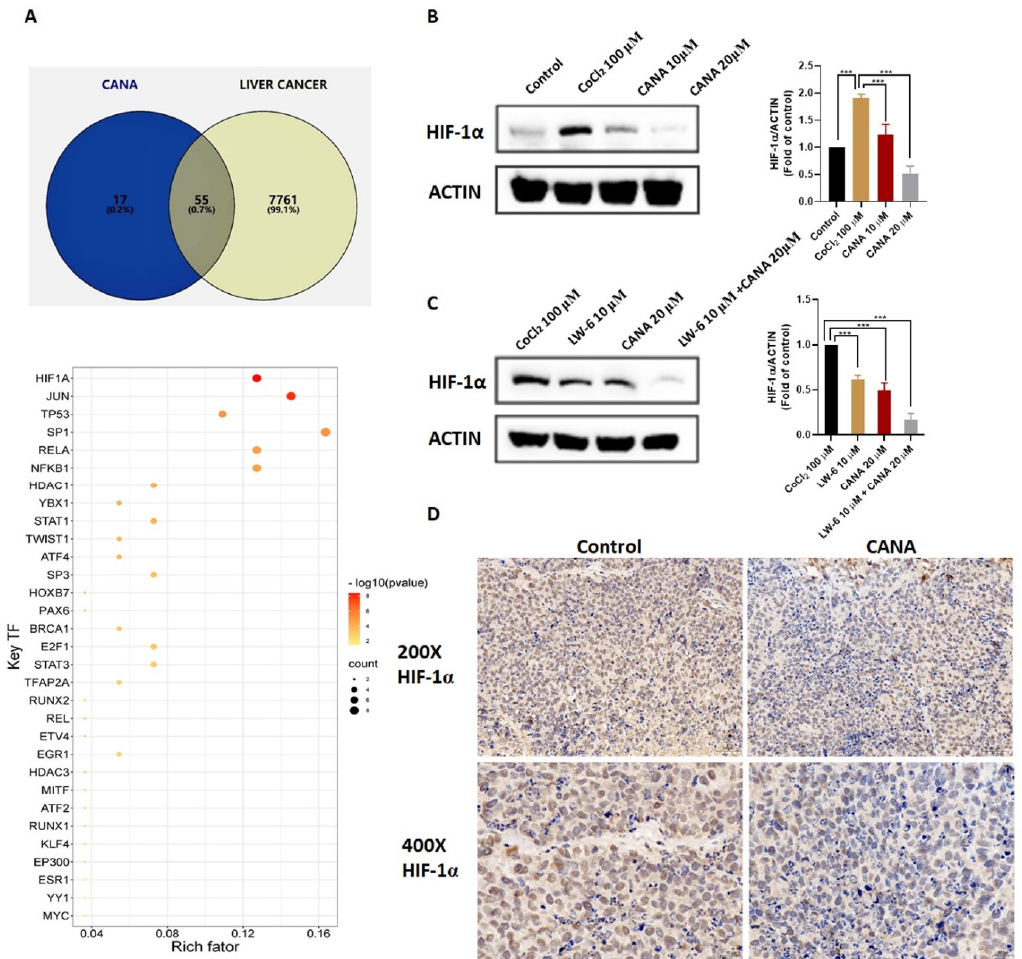
Figure 5. CANA inhibited accumulation of HIF-1 α . ( A ) Venn diagram of the common targets between liver cancer-related targets and CANA potential targets and bubble plot of the key regulators for overlapping genes. ( B ) Expression of HIF-1 α protein in HepG2 cells exposed to CoCl 2 in the presence or absence of CANA. ( C ) Expression of HIF-1 α protein in HepG2 cells exposed to CoCl 2 in the presence of LW-6, CANA, or both. ( D ) Representative tumor tissue sections showing expression of HIF-1 α protein detected immunohistochemically in the indicated groups (200X, 400X). Data were shown as means ± S.D. ( n = 3); *** p < 0.001. Control, normal untreated control; CANA, CANA-treated CoCl 2 (100 μ M)-induced group; LW-6, LW-6-treated CoCl 2 (100 μ M)-induced group; LW-6 + CANA, LW-6-treated CANA-treated CoCl 2 (100 μ M)-induced group.